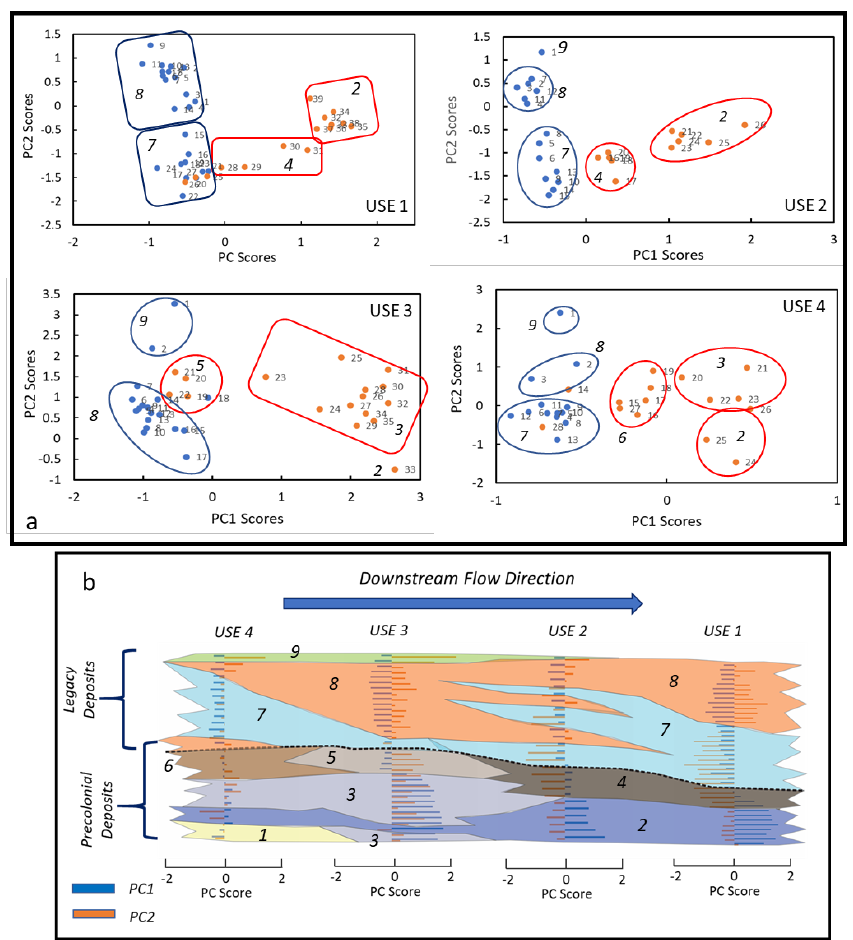
Figure 6. ( a ) X-Y plots of component scores used to define the chemostratigraphic units at USE 1, USE 2, USE 3, and USE 4. Chemostratigraphic units were plotted as clusters of samples on the plots, each of which are encompassed by a colored circle. Orange circles denote chemostratigraphic units within the precolonial deposits; blue circles represent units within the legacy deposits. Groupings were subjectively defined. The PC scores for unit 1 at Site USE 4 overlap with unit 7. ( b ) Defined and correlated chemostratigraphic units within the study reach. Bar graphs show component scores that were used to define the chemostratigraphic units. Italicized numbers in ( a ) and ( b ) refer to chemostratigraphic units, defined from oldest to youngest, and allow for correlation between plots. Table 3. Summary of general component scores for chemostratigraphic